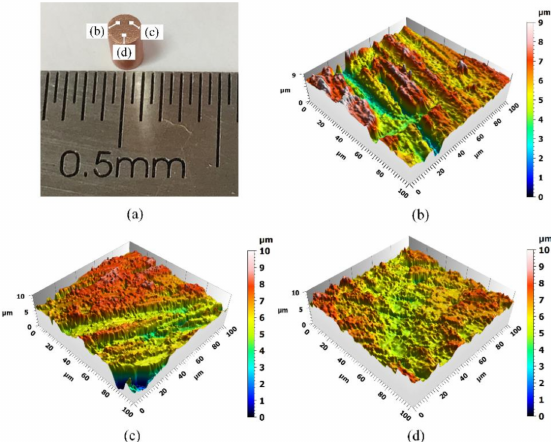
Figure 16. Surface roughness of pretreated cylindrical specimen with ( a ) roughness measurement positions as ( b ) S qin = 1.58 µ m, ( c ) S qin = 1.56 µ m, and ( d ) S qin = 1.57 µ